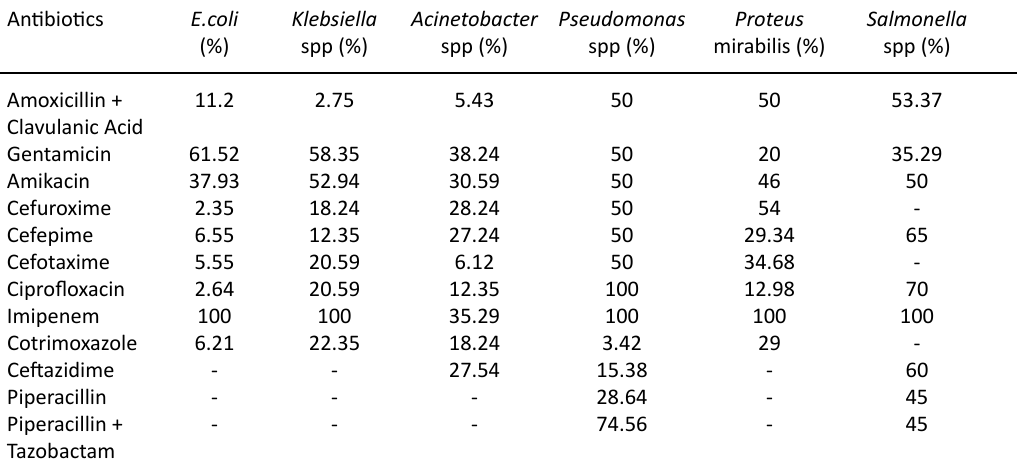
Table 4. Antibiotic sensitive pattern of Gram negative organisms(53) Antibiotics E.coli Klebsiella Acinetobacter Pseudomonas Proteus Salmonella